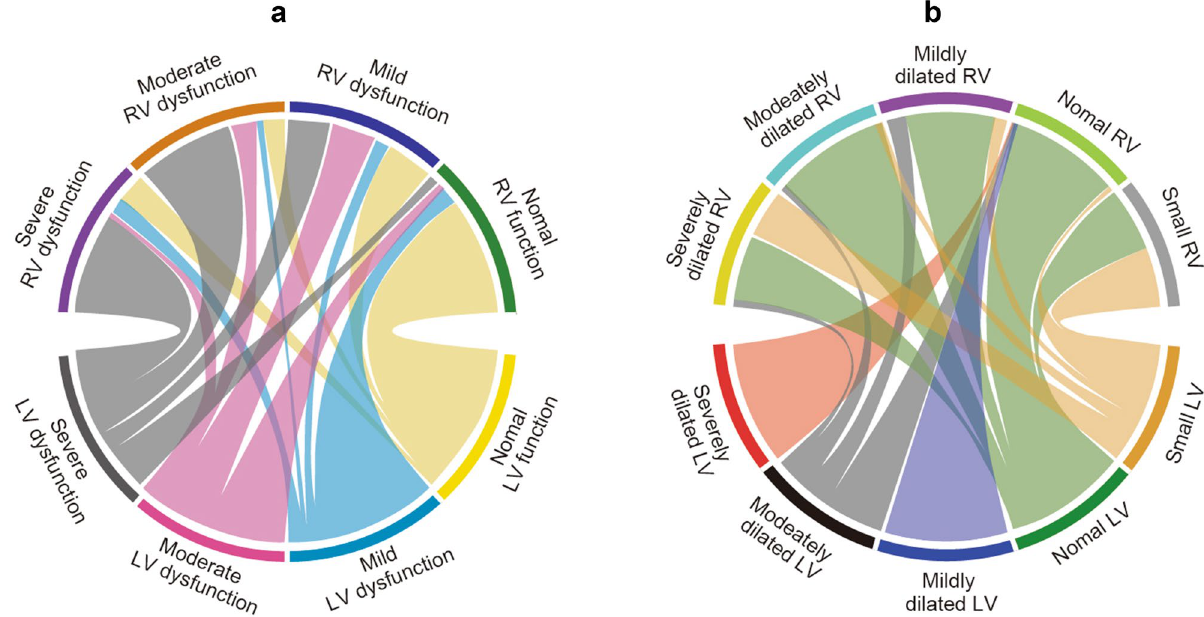
Figure 2. Chord diagrams. Relationships (a) between LV systolic dysfunction and RV dysfunction and (b) between LV size and RV size in patients with septic shock. LV left ventricle, RV right